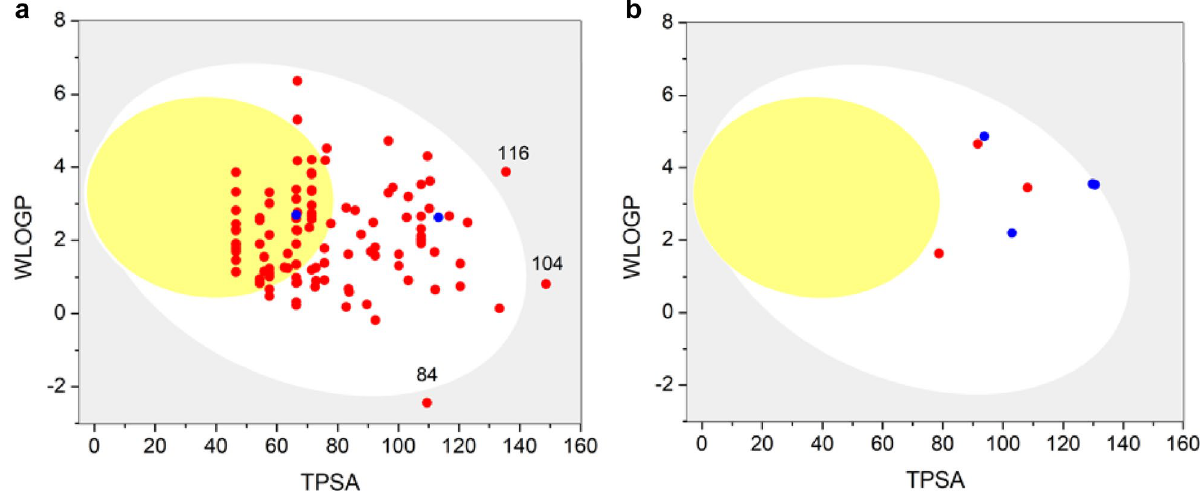
Figure 14. Boiled egg of ( a ) all the compounds in the database and ( b ) 7 best compounds from the screening showing probability of human intestinal absorption (HIA) and blood–brain barrier (BBB) permeation of the studied molecules.